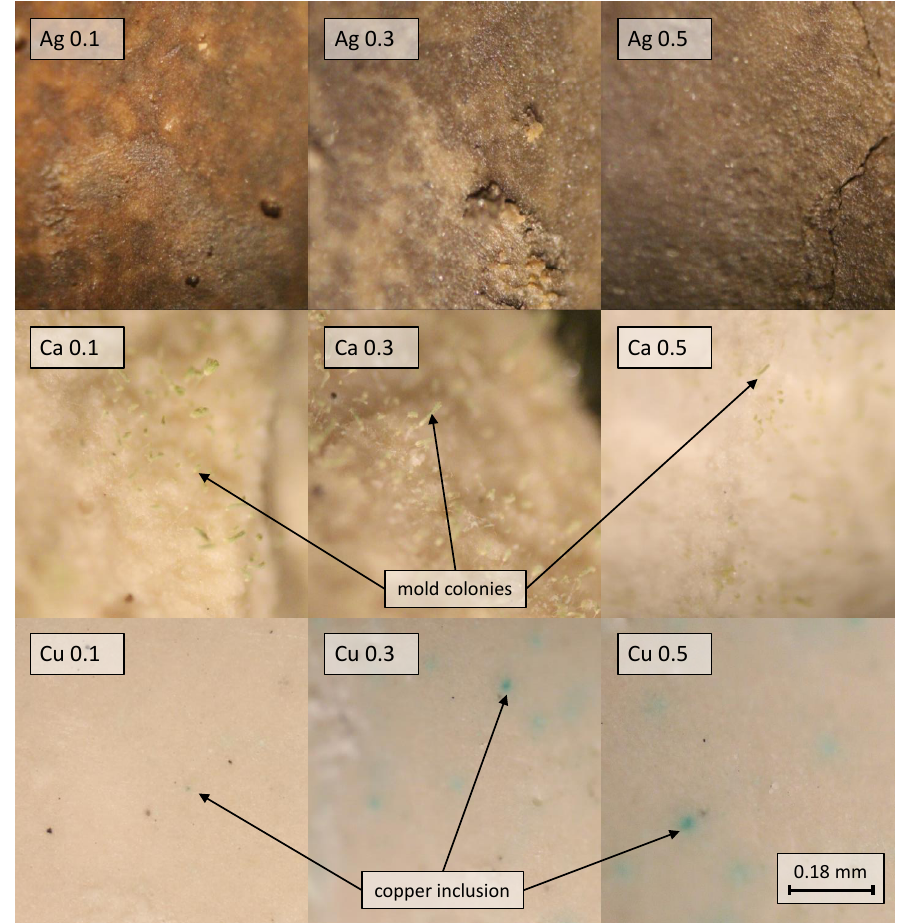
Figure 4. Optical microscope images of tested materials. magnified 120